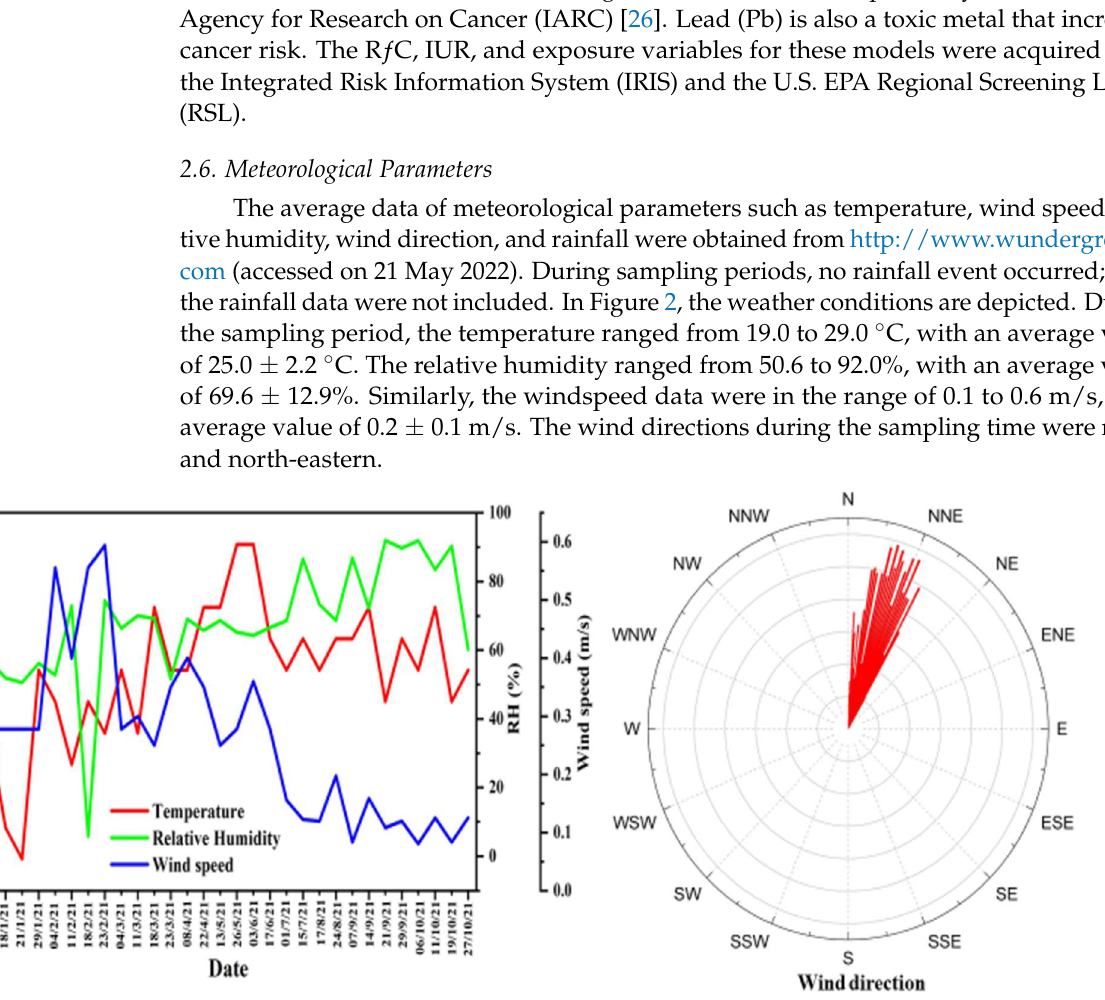
Figure 2. Meteorological parameters, such as temperature, wind speed, relative humidity, and wind direction, during the sampling period in Bangkok metropolitan area, Thailand.